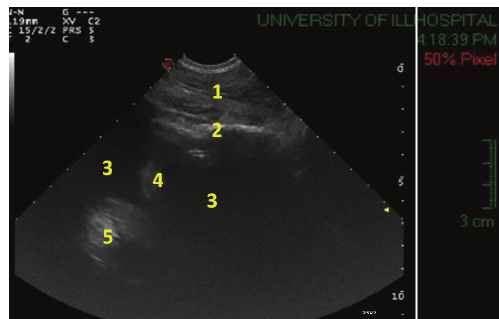
Figure 5: Ultrasonogram of pericardial e ff usion obtained by 3.5MHz convex transducer placed in the distal fifth intercostal space on the left thorax. 1: thoracic wall; 2: thickened pericardium; 3: massive hypoechogenic pericardial e ff usion; 4: fibrin strands; 5: ventricular wall.